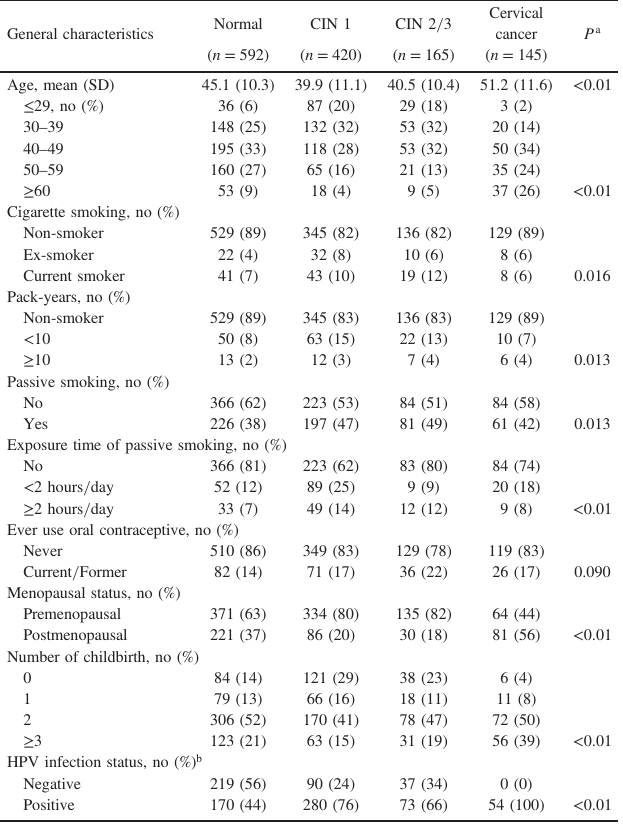
Table 1. Selected characteristics and smoking habits of study participants General